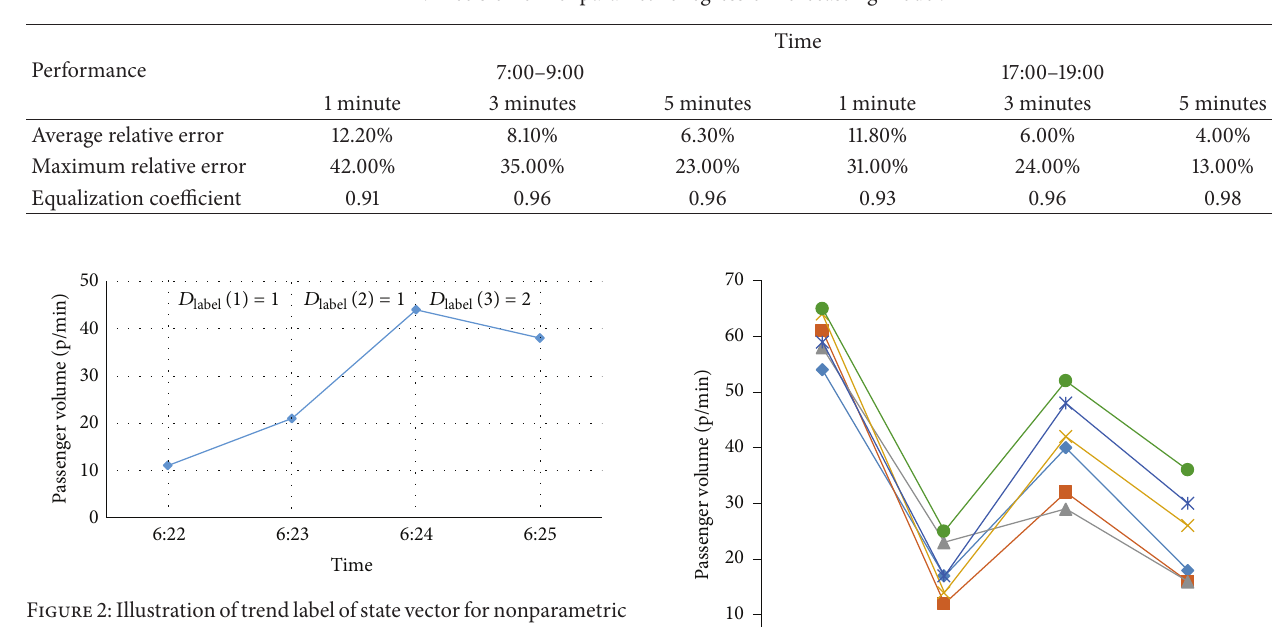
Table 1: Precision of nonparametric regression forecasting model.